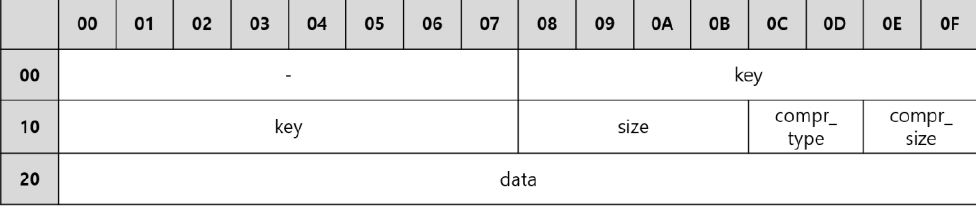
Figure 15. UBIFS data node in form of hex value.